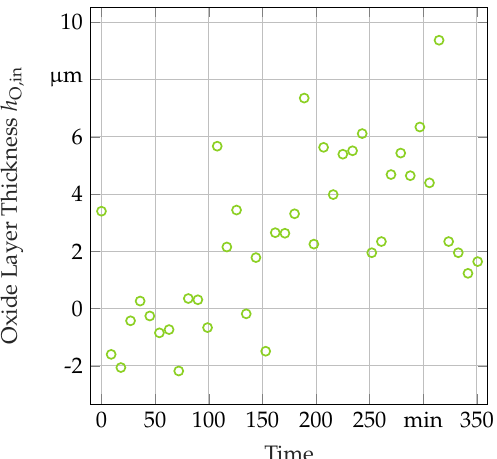
Figure 10. Calculated oxide layer thickness h O,in over the time spent in the HT for sample 2 based on in-situ XRD measurements.